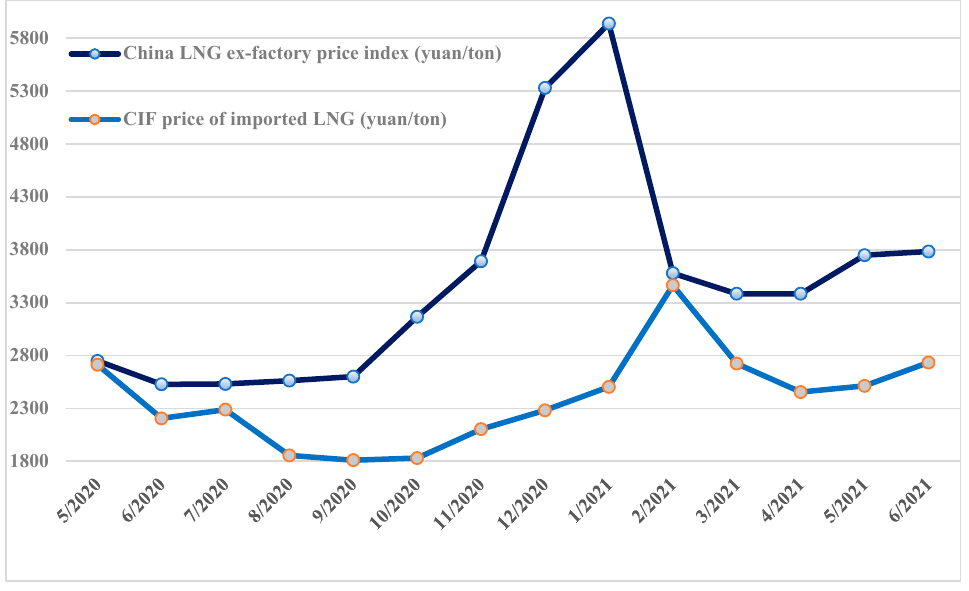
Figure 4. May 2020–June 2021 Gas price trend.